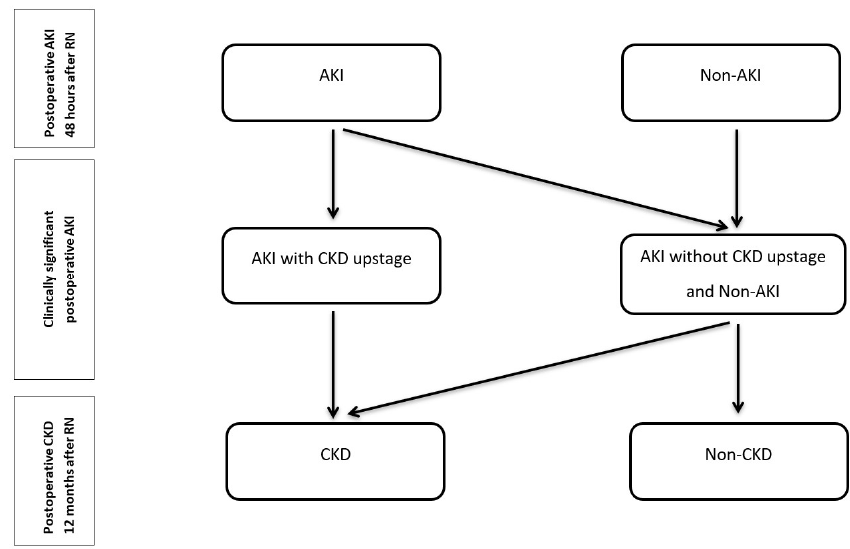
Figure 2. The formation of study cohorts. Abbreviations: RN—radical nephrectomy; CKD–chronic kidney disease; AKI—acute kidney injury.